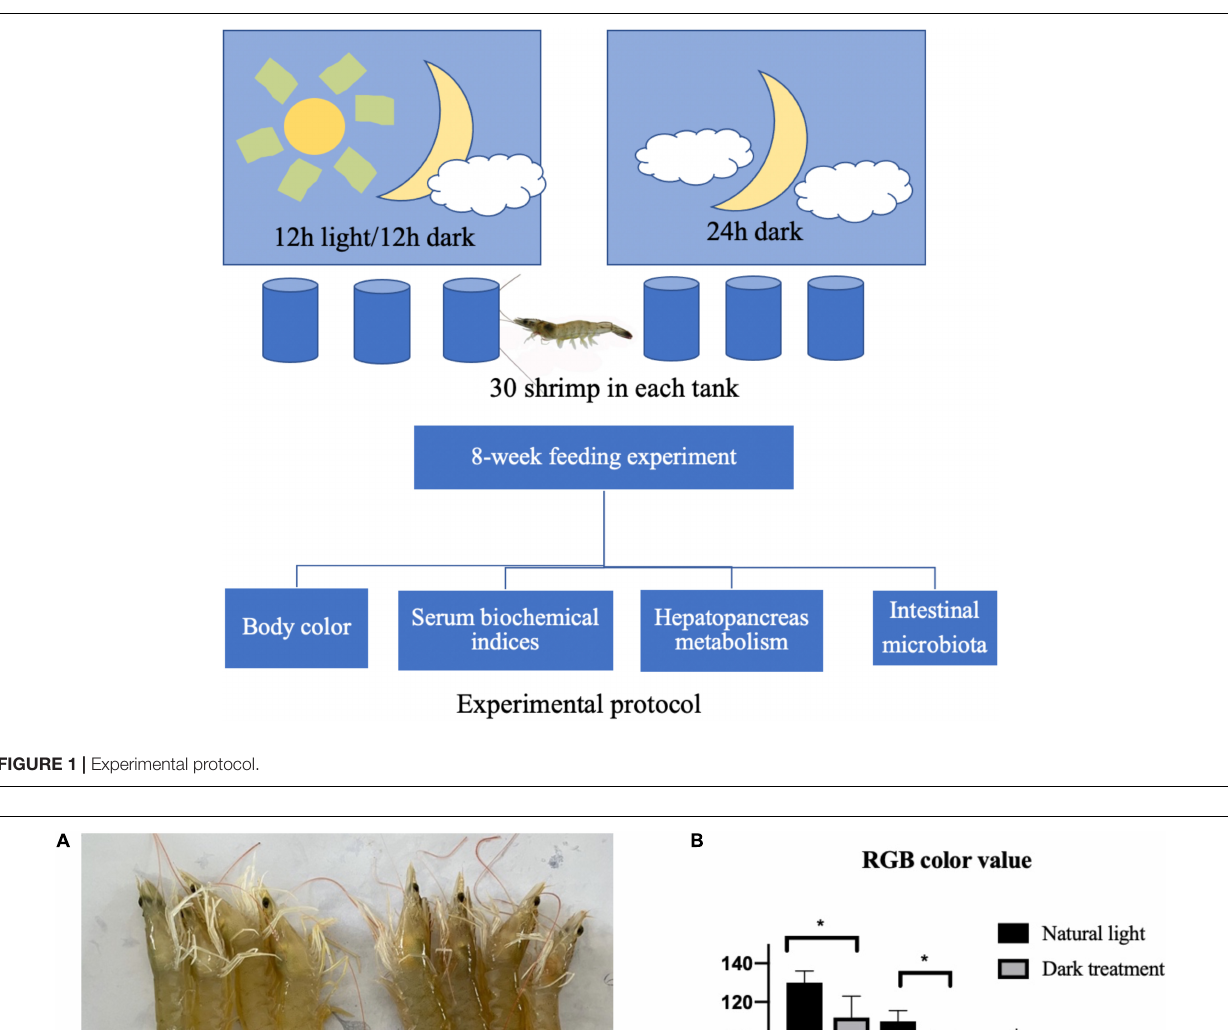
FIGURE 2 | The body color of Litopenaeus vannamei. (A) Image captured by digital cameras. (B) Analysis of red, green, and blue (RGB) color values based on images. *indicated significantly difference among tow groups ( P <